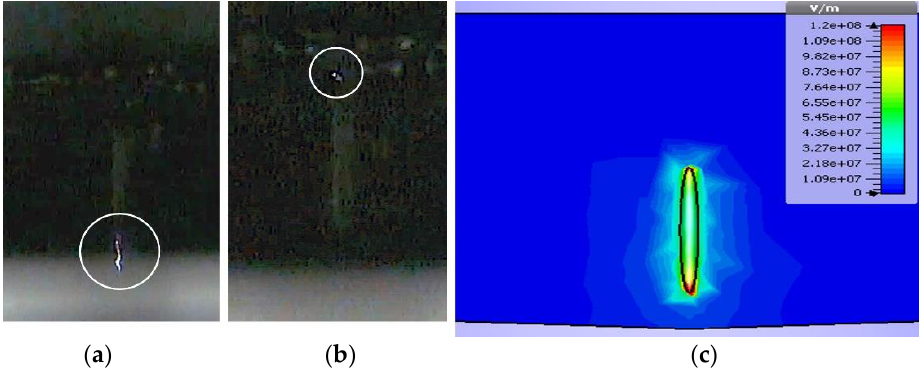
Figure 10. Corona for 8 mm of particle size and d = 2 mm at voltage stress of 64.2 kV: ( a ) corona at the bottom of particle; ( b ) corona at the top of particle; and ( c ) simulation result of E -field distribution.